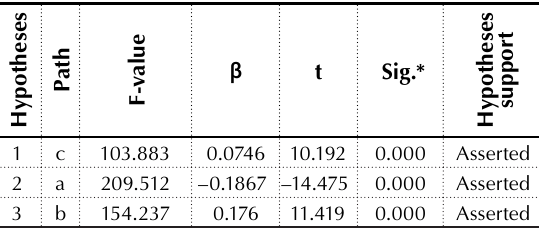
Table 4. Regression analysis